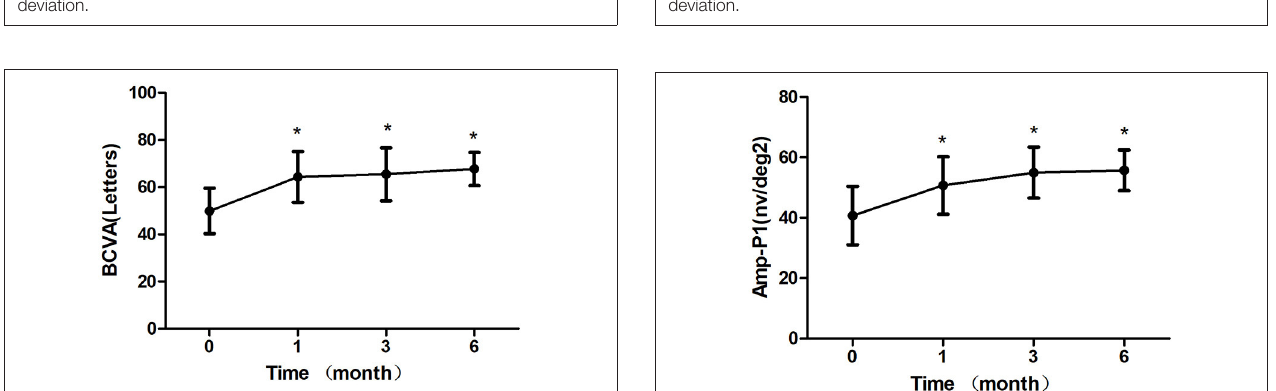
FIGURE 2 | Mean change in choroidal neovascularization (CNV) area over 6 month. The significant reduction of CNV area were observed at 6 month compared with baseline values (* P < 0.05). Error bar represents standard deviation.